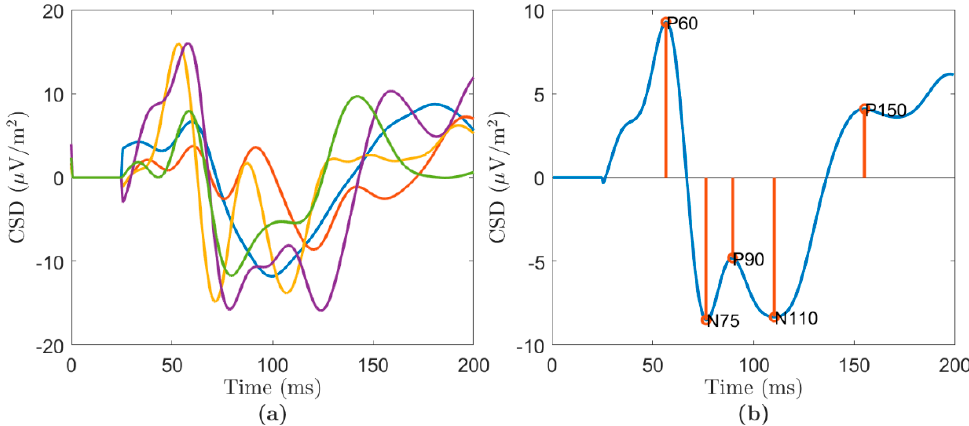
Figure 5. ( a ) ROI-averaged TEPs for the ROI of nine central channels and for individual subject, and ( b ) the average across subjects TEP, along with identified components. ( b ) the average across subjects TEP, along with identified